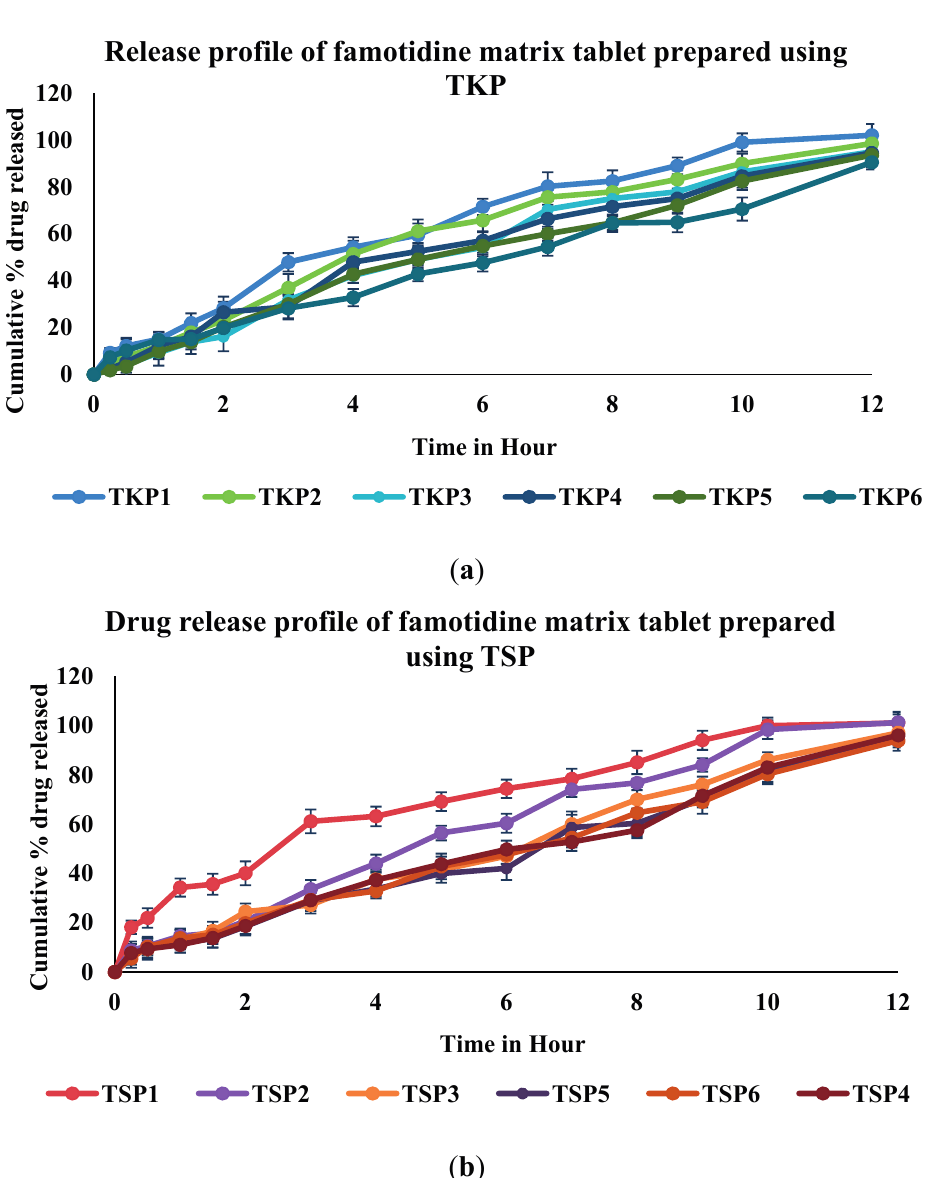
Figure 10. Cumulative percentage of famotidine release from ( a ) TKP and ( b ) TSP formulations within 12